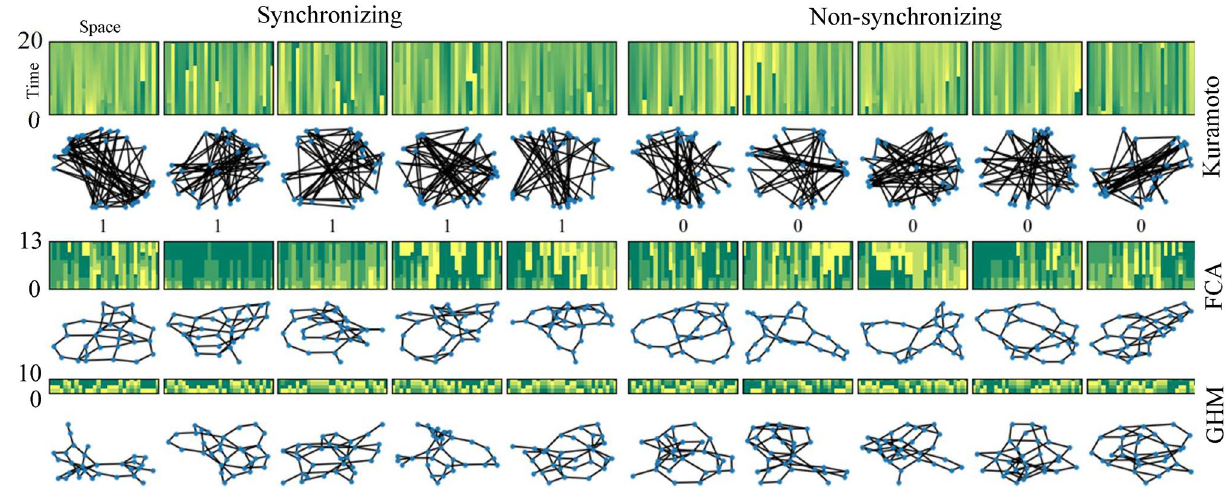
Figure 4. Sample points in the 30-node training data set for synchronization prediction. The full dataset consists of 40 K synchronizing and 40 K non-synchronizing 30-node connected non-isomorphic graphs and dynamics on them for each of the three models the KM, FCA, and GHM (see Table 2).